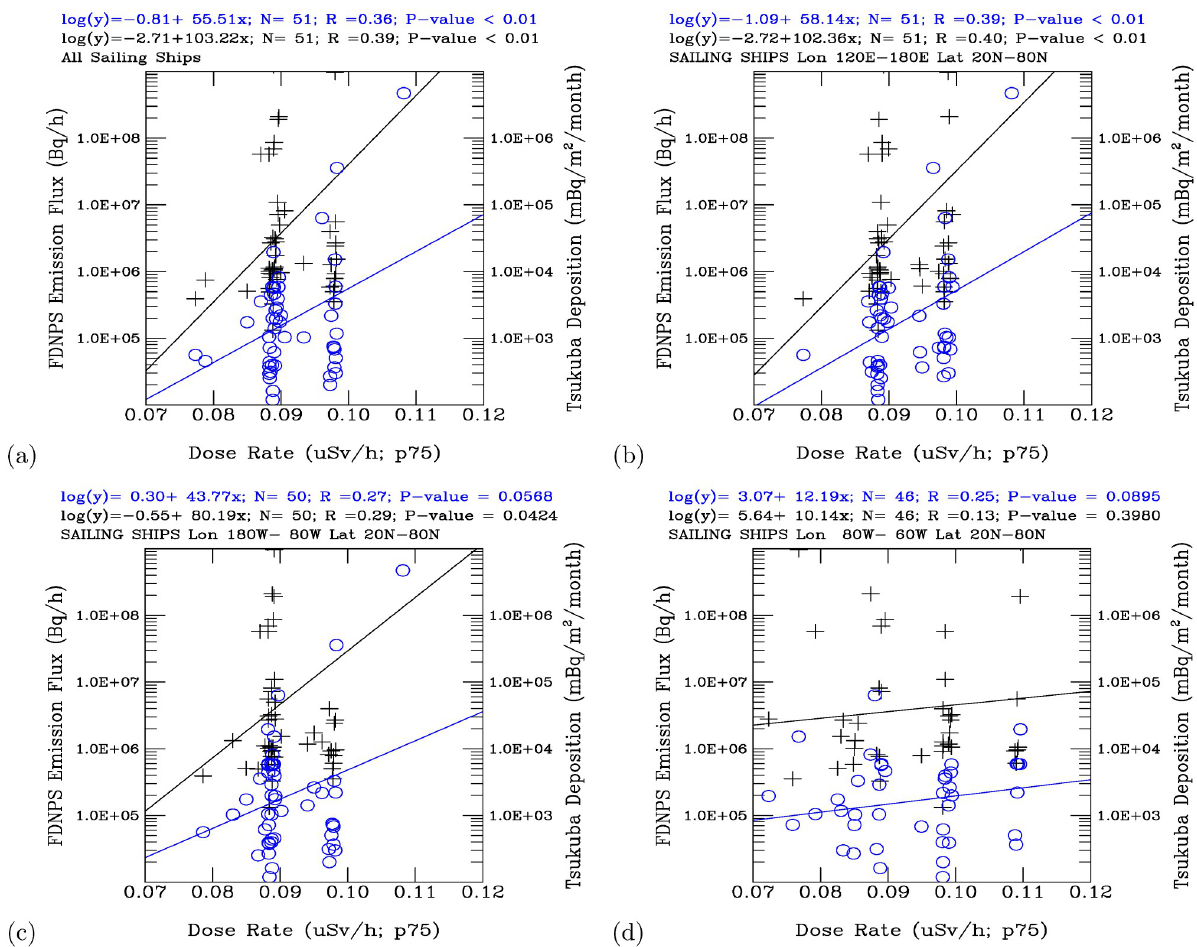
Fig 8. Scatter plot analysis of the FDNPS radiocesium emission fluxes (black crosses) and measured Tsukuba deposition fluxes (blue circles) versus the monthly 75 th percentile (p75) air dose rates on sailing ships. (a) North Pacific Ocean. (b) Northwest Pacific Ocean. (c) Northeast Pacific Ocean. (d) Northwest Atlantic